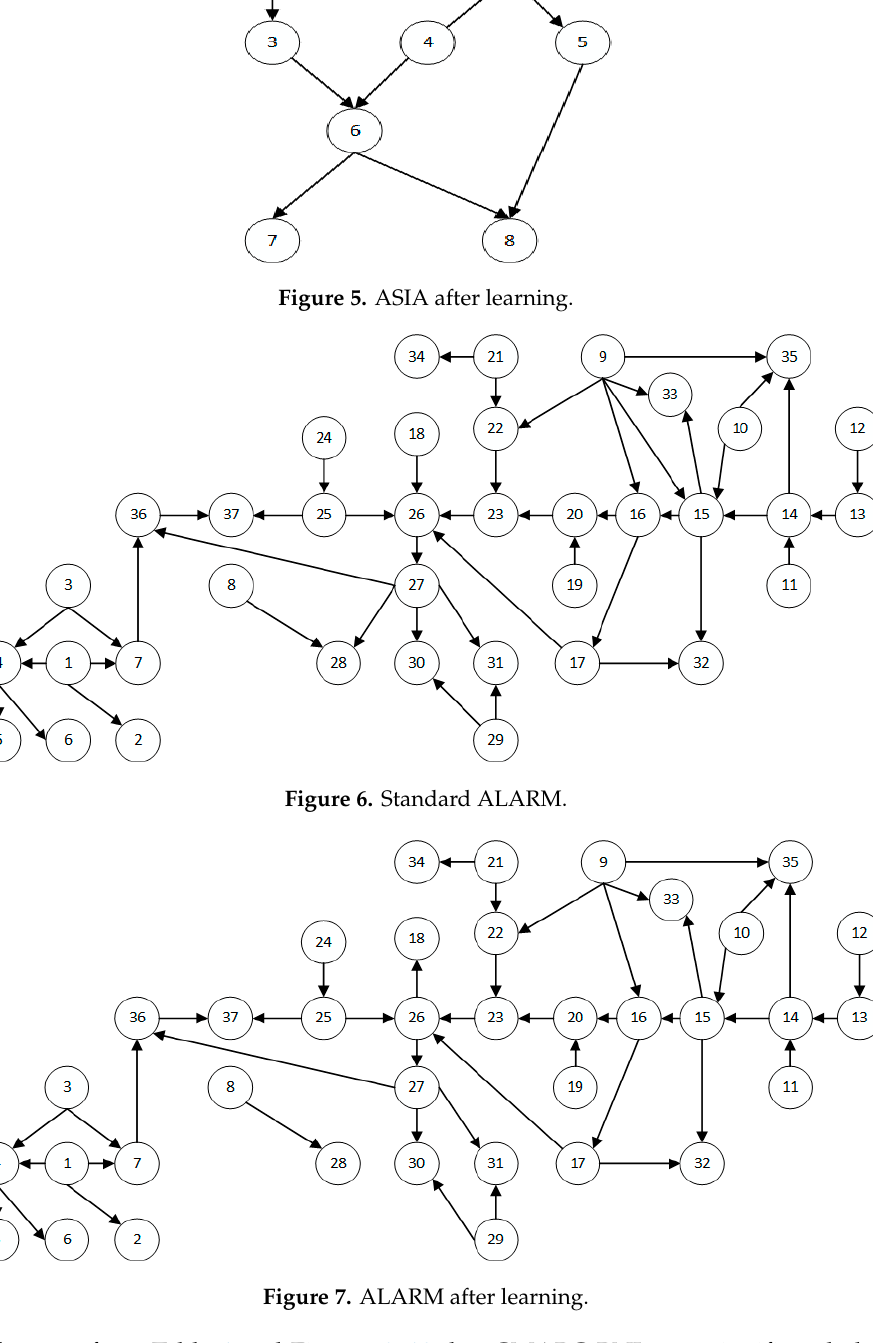
Figure 7. ALARM after learning.